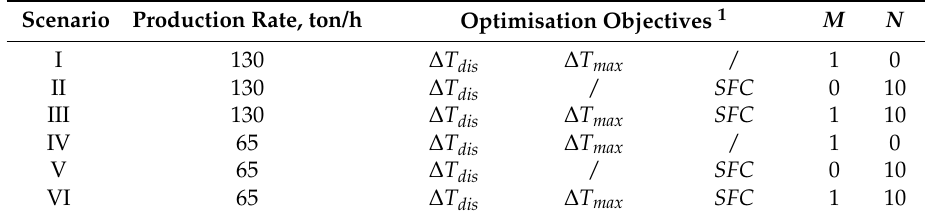
Table 1. Specification of different optimisation scenarios and weighted